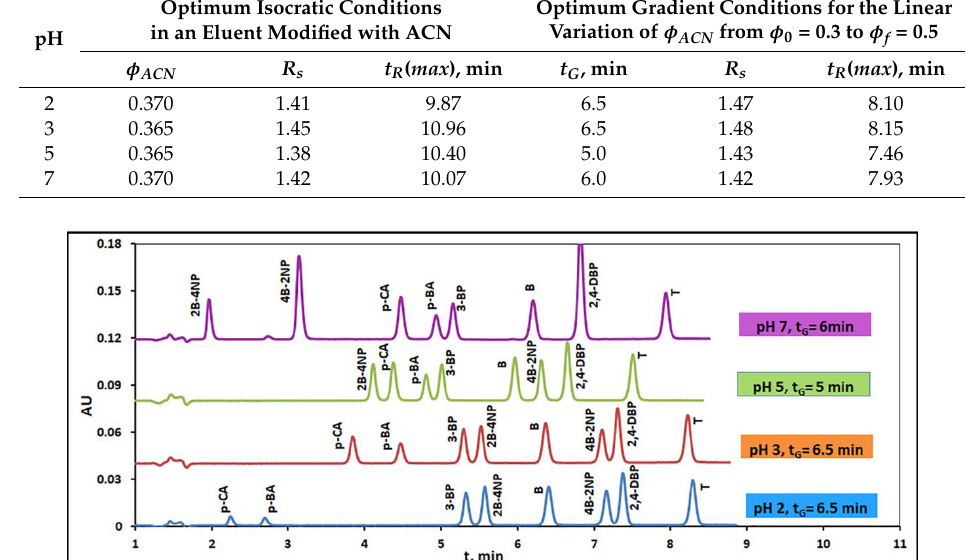
Table 1. Optimal conditions found for the separation of the mixture of solutes using an Excel spreadsheet-based optimization program.